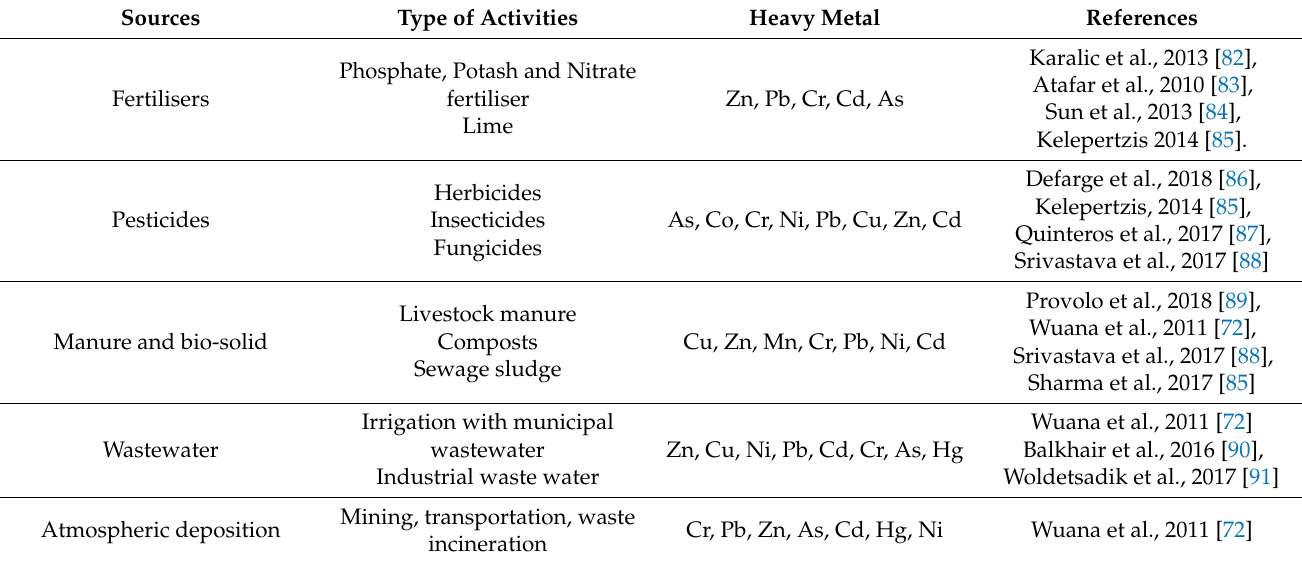
Table 3. Sources of heavy metals in agricultural